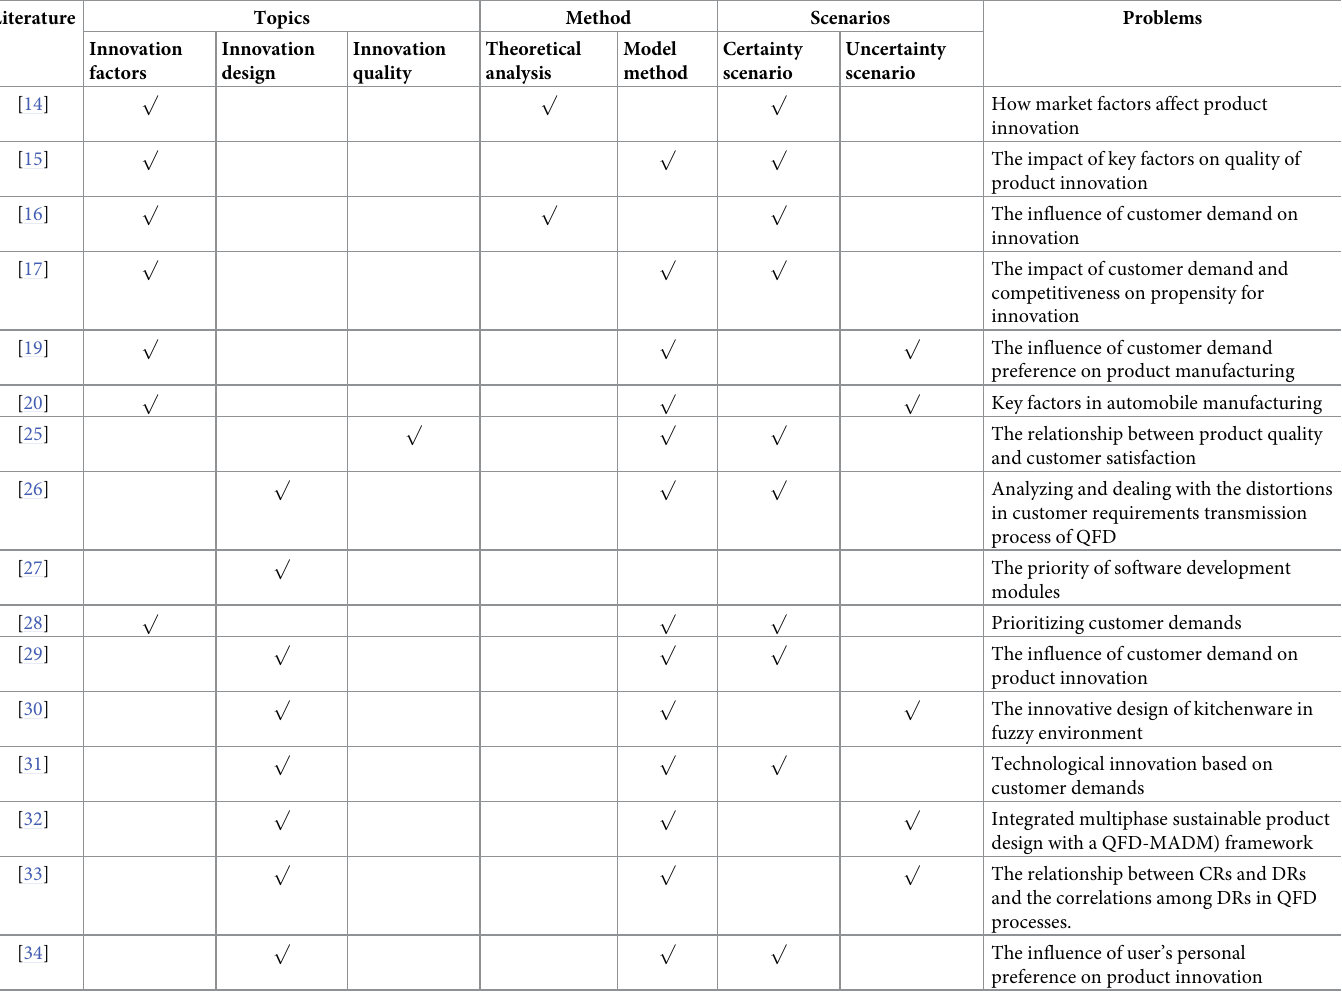
Table 1. Product innovation literature (partial)